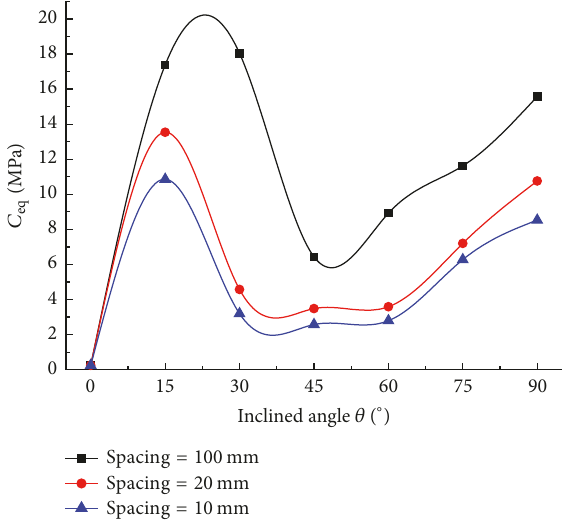
Figure 13: Equivalent cohesion of the specimens with various bedding plane